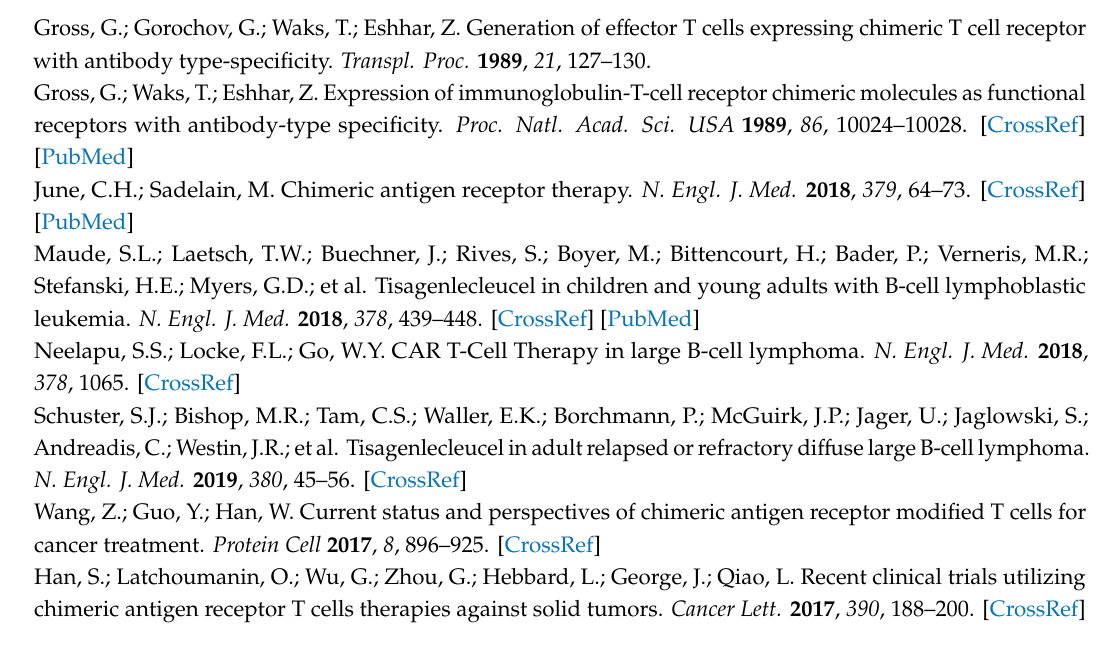
Table S1: Characteristics of all clinical trials using CAR-T cells against solid tumors. Data was collected from clinicaltrials.gov and literature search on pubmed.ncbi.nlm.nih.gov; Table S2: Summary of clinical trials reporting on clinical outcome. Data was collected from clinicaltrials.gov and literature search on pubmed.ncbi.nlm.nih.gov. Funding: This research was funded by the Deutsche Forschungsgemeinschaft (German Research Foundation), trilateral grant SCHA 1247 /